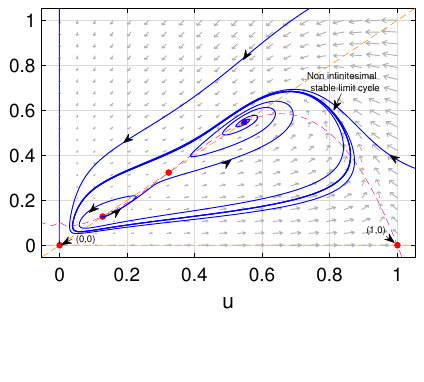
Figure 10. For A = 0 . 0245 , B = 0 . 001 , S = 0 . 01 and Q = 0 . 2675, there exists a non-infinitesimal limit cycle surrounded three positive equilibrium points, one of them ( u e 1 ,u e 1 ) to the left, is a repeller node, ( u e 2 ,u e 2 ) to the right is an attractor focus. The point (0 , 0) is a non-hyperbolic saddle and (1 , 0) is a hyperbolic